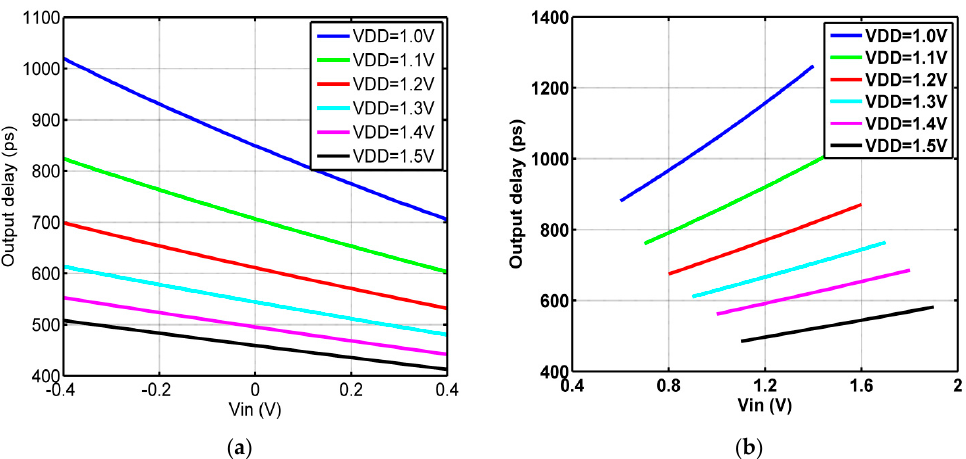
Figure 18. ( a ) Output delay of the first proposed VTC for different supply voltages. ( b ) Output delay of the second proposed VTC for different supply voltages.